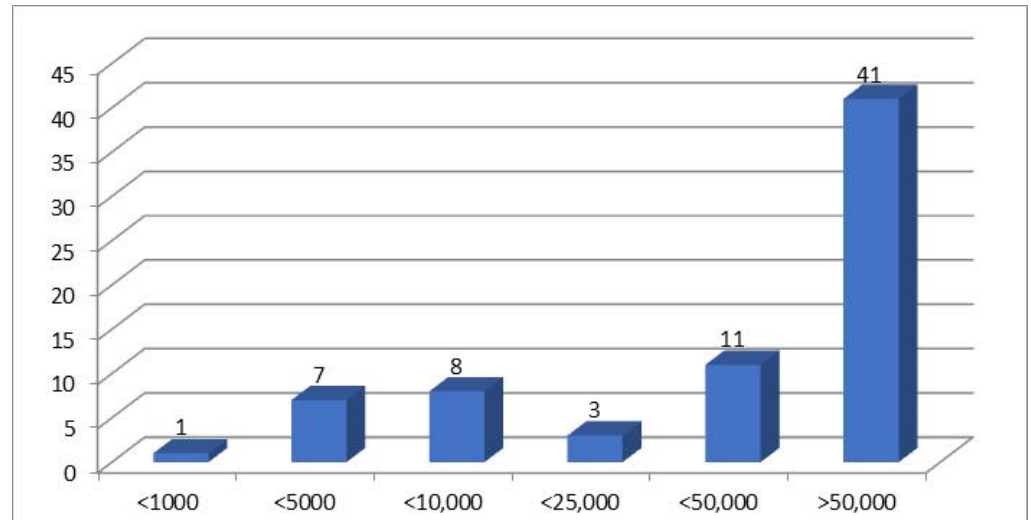
Figure 3. Frequency histogram of the number of areas in which the stakeholders act per number of inhabitants (x axis).